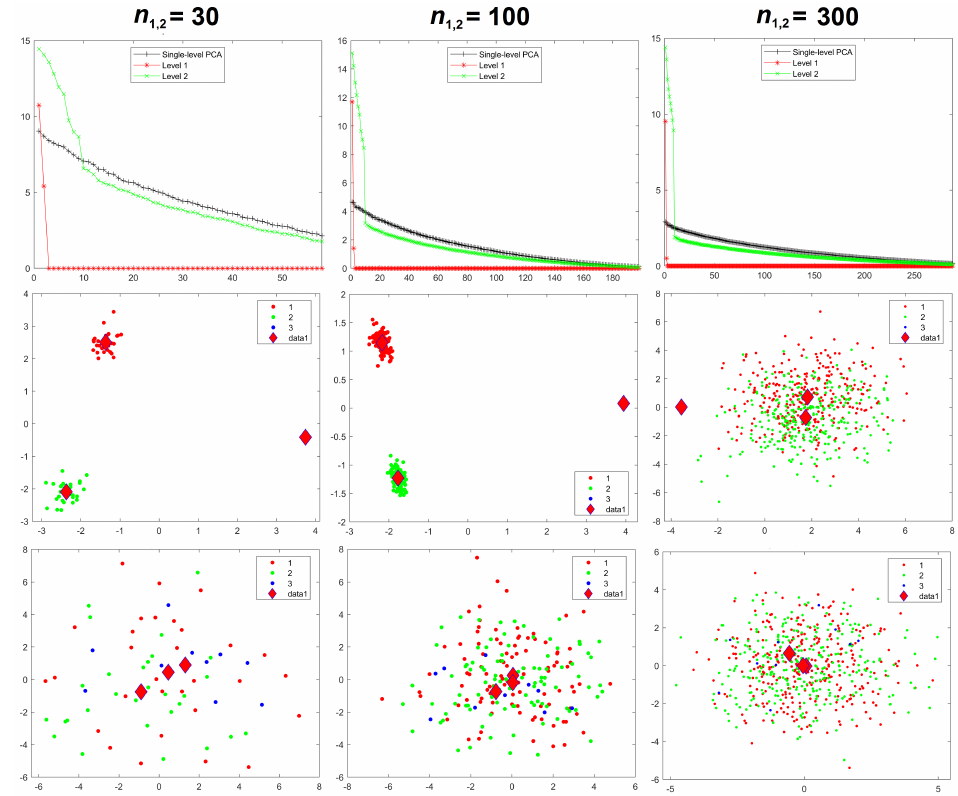
Figure 5. Experiment 2a: eigenvalues ( upper row ), mPCA, level 1 component scores ( middle row ), and single-level PCA, component scores ( bottom row ) for sample sizes per group of n 1,2 = 30 ( left- hand column ), n 1,2 = 100 ( middle column ), and n 1,2 = 300 ( right-hand column ) in groups 1 and 2. Note that n 3 = 10 in group 3 in all simulations for Experiment 2a. Group centroids for are shown by the diamonds; x -axis = first component; y -axis = second